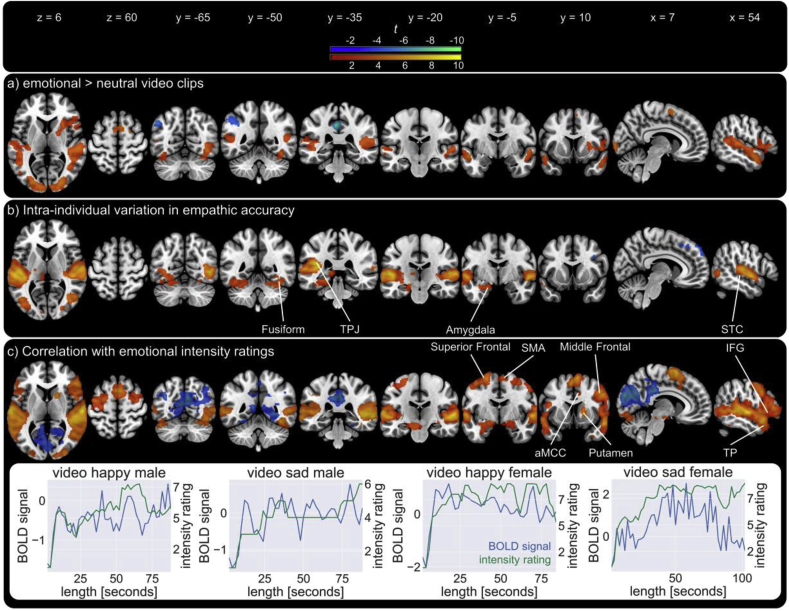
Neural substrates of changes in empathy. a) Significant brain activations when viewing emotional video clips compared to neutral ones. b) Regions significantly positively (red) and negatively (blue) modulated by variations in empathic accuracy (Z-EA scores). c) top: Brain areas significantly positively correlated over time with the participants' ratings of the target's emotional intensity. bottom: BOLD response (after first level regression) of significant clusters (blue) and participant's ratings of the target's emotional intensity (green) of one exemplary participant. Key: STC - superior temporal cortex, TP - temporal pole, TPJ - temporoparietal junction, IFG - inferior frontal gyrus, SMA - supplementary motor area, aMCC - anterior midcingulate cortex.